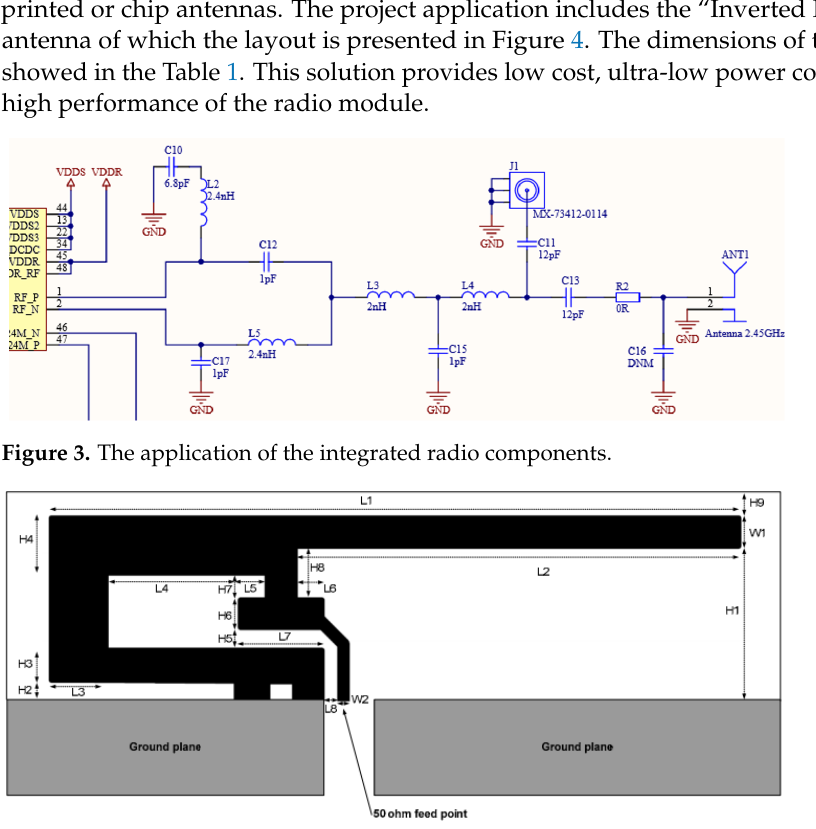
Figure 4. Inverted F PCB printed antenna